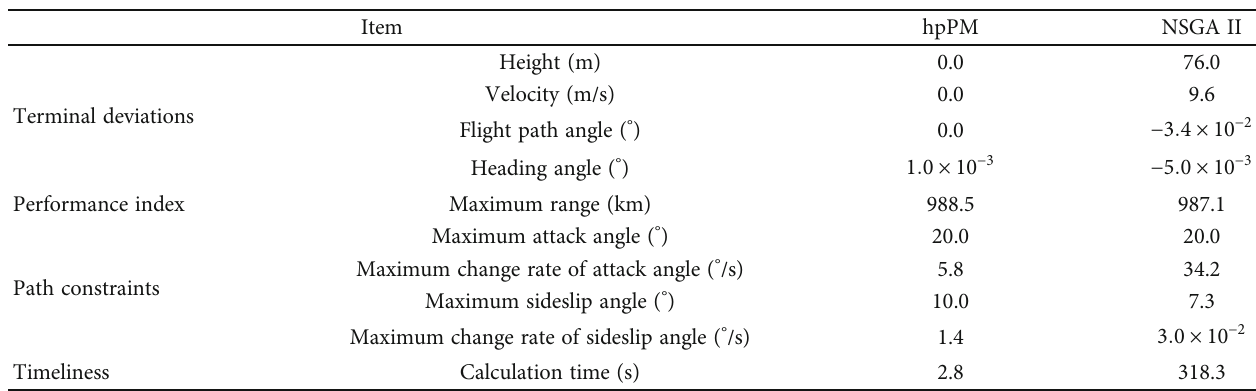
Figure 21: Pareto front. Table 9: Comparison